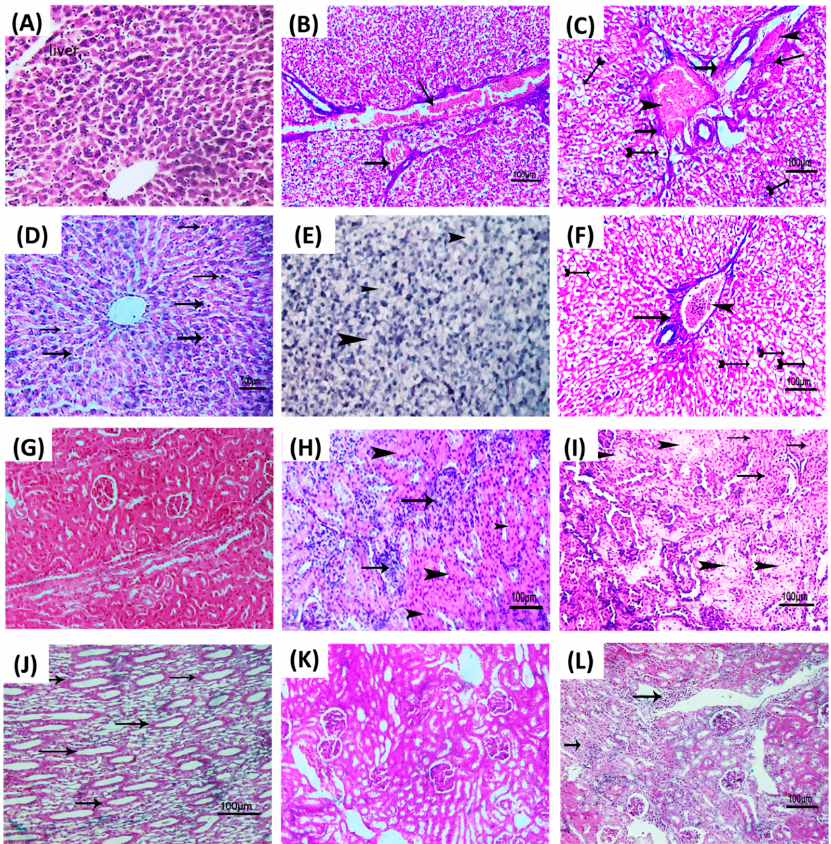
Figure 6. Linagliptin diminishes the P. aeruginosa pathogenesis. Histopathological photomicrographs of the liver and kidney tissues (H&E × 200) are captured from mice groups that were uninfected, P. aeruginosa infected, or P. aeruginosa treated with linagliptin (2 mg/mL). ( A ) Photomicrograph of liver tissues obtained from uninfected (control) mice group showing normal tissue architecture and cellular details. ( B ) Photomicrograph liver section of mice group infected with untreated P. aeruginosa, showing severe congestion of hepatic blood vessels (arrows). ( C ) Photomicrograph liver section of mice group infected with untreated P. aeruginosa showing perivascular fibrosis (arrows) with con- gestion of hepatic blood vessel (arrowhead) and hydropic degeneration of some hepatocytes (tailed arrow). ( D ) Photomicrograph liver section of mice group infected with P. aeruginosa treated with linagliptin showing mild diffuse infiltration of von Kupffer cells (arrows). ( E ) Photomicrograph liver section of infected mice group infected with P. aeruginosa treated with linagliptin showing vacuolation of few hepatocytes in the hepatic parenchyma (arrows). ( F ) Photomicrograph liver section mice group infected with P. aeruginosa treated with linagliptin showing mild cellular infiltration (arrow) with congested hepatic blood vessels (arrowhead) and diffuse vacuolation of some hepatocytes (tailed arrows). ( G ) Photomicrograph of kidney tissues obtained from uninfected (control) mice group showing normal renal cortex with normal glomeruli and renal tubules. ( H ) Photomicrograph kidney section of mice group infected with untreated P. aeruginosa , showing degenerative changes of renal tubules represented in cloudy swelling (arrowhead) with focal areas of cellular proliferation (arrows). ( I ) Photomicrograph kidney section of mice group infected with untreated P. aeruginosa, showing focal caseous necrosis (arrowhead) with cloudy swelling of some renal tubules (arrows) in renal parenchyma. ( J ) Photomicrograph kidney section of mice group infected with P. aerugi- nosa treated with linagliptin showing mild diffuse cystic dilation of some renal tubules (arrows). ( K ) Photomicrograph kidney section of mice group infected with P. aeruginosa treated with linagliptin showing apparently normal renal cortex. ( L ) Photomicrograph kidney section of mice group infected with P. aeruginosa treated with linagliptin showing fewer focal areas of cellular infiltration (arrows), bar = 100 µ